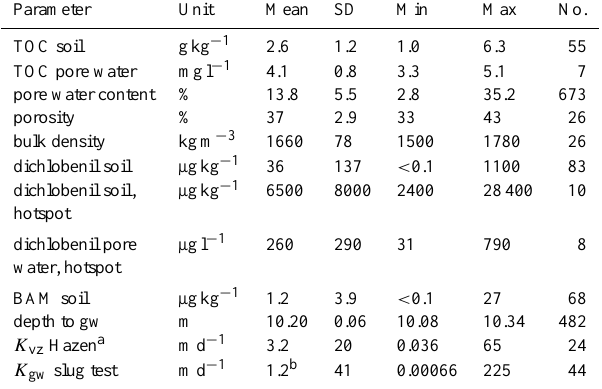
Table 1. Analysis of soil samples taken in six, 5 to 10m deep, soil profiles from the nursery site, including data from Bergvall et al. (2007), and slug tests carried out in the aquifer (Fig. 2). Except for the hydraulic conductivity ( K gw ) measurements from slug tests, all data refer to the vadose zone. For each parameter the mean, stan- dard deviation (SD), observed range and number of observations are reported. When the concentration was less than the detection limit (0.1µgkg − 1 ) 0.05µgkg − 1 was used in the calculation of the mean and standard deviation.